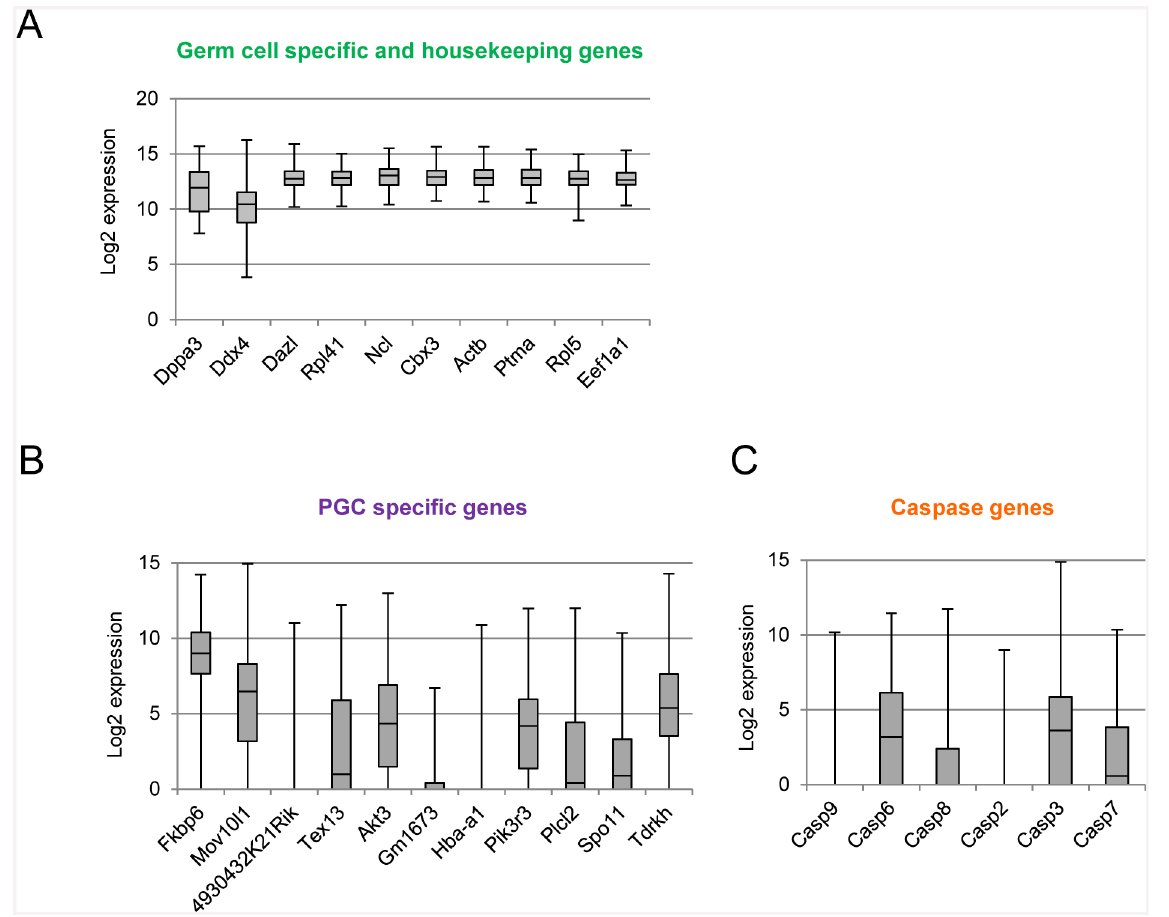
Fig 5. Expression patterns of representative genes in individual PGCs. (A) Uniform expression patterns of housekeeping and germ cell-specific genes among individual PGCs. (B, C) Heterogeneous expression pattern of PGC-specific and apoptosis-related genes. Expression levels are shown in log2 values. Gene symbols were ranked in the order of higher log (FC) values. Box plots show the central 75% (grey boxes), median (black lines), and range (whiskers).